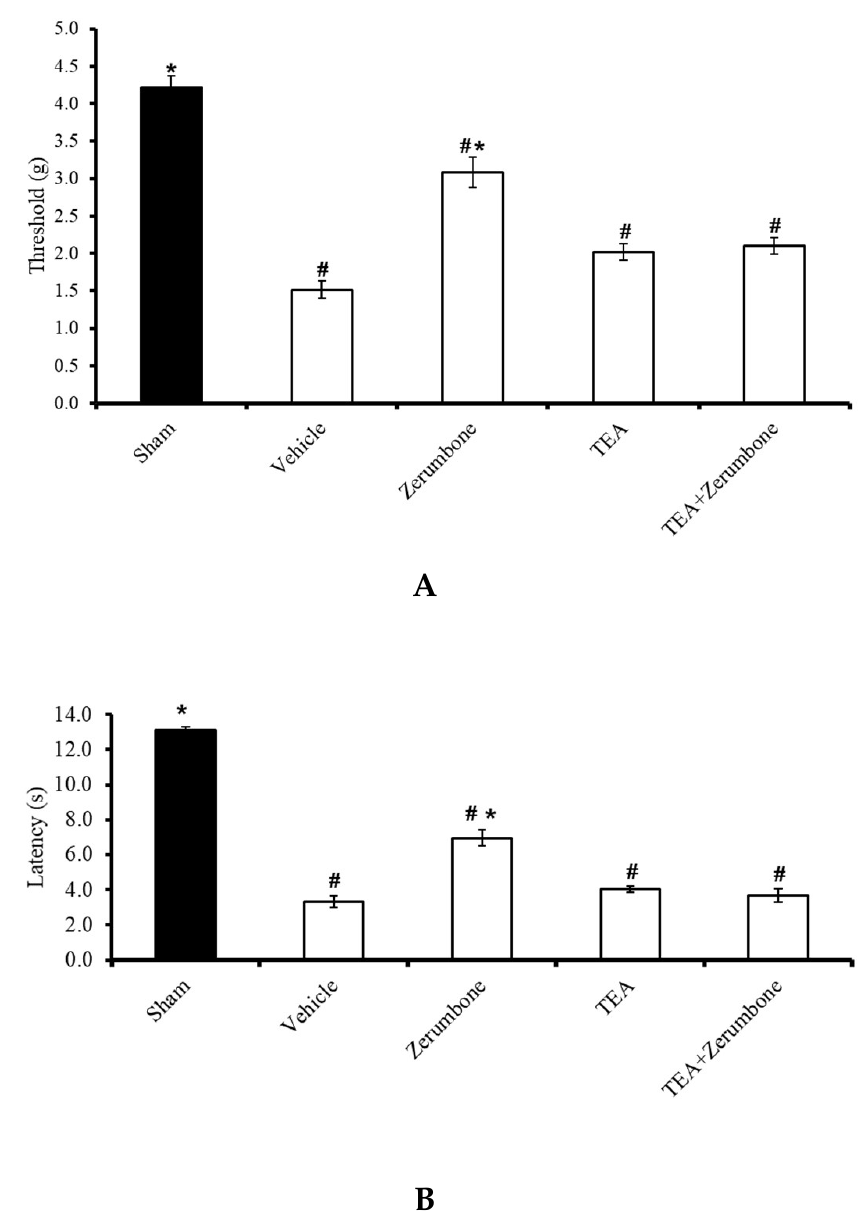
Figure 1. E ff ect of zerumbone (10 mg / kg; i.p.) and pre-treatment with a voltage-dependent K + channel blocker (tetraethylammonium, TEA; 4 mg / kg; i.p.) on the responses toward ( A ) mechanical allodynia and ( B ) thermal hyperalgesia on chronic constriction injury (CCI)-induced neuropathic pain in mice. Each column represents the mean ± SEM; n = 8 mice per group. Note: # significantly di ff erent ( p ≤ 0.05) than sham group; * significantly di ff erent ( p ≤ 0.05) than vehicle group (one-way ANOVA followed by Tukey’s post hoc test).